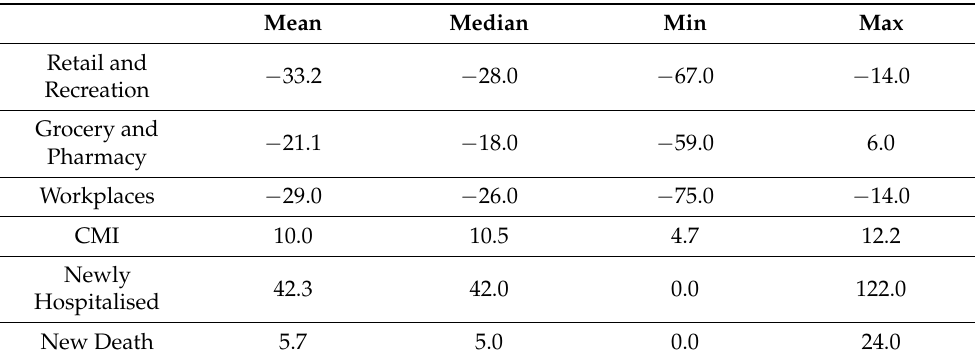
Table 1. Descriptive statistics of the CMR, CMI, hospitalization and death.